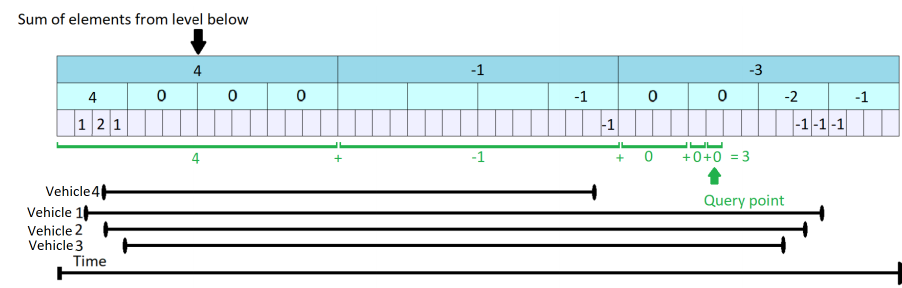
Figure 11. KEP Tree Query at Time t =